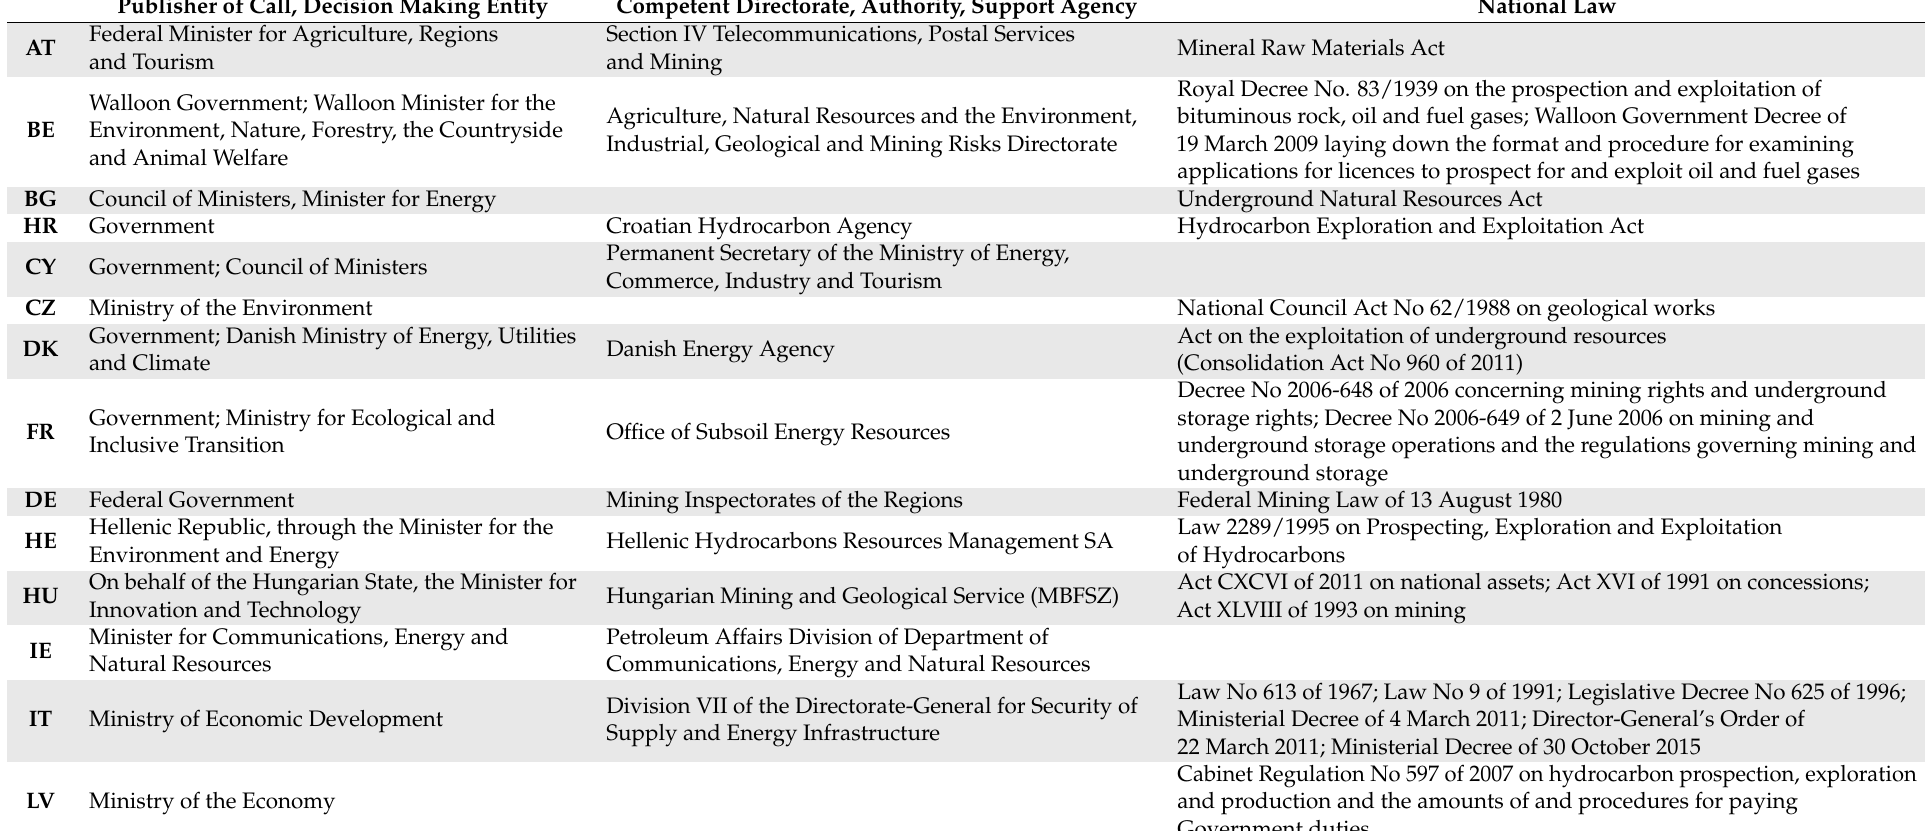
Table 2. The regulatory framework supervising the hydrocarbons exploration and production activities, as extracted from the recently published